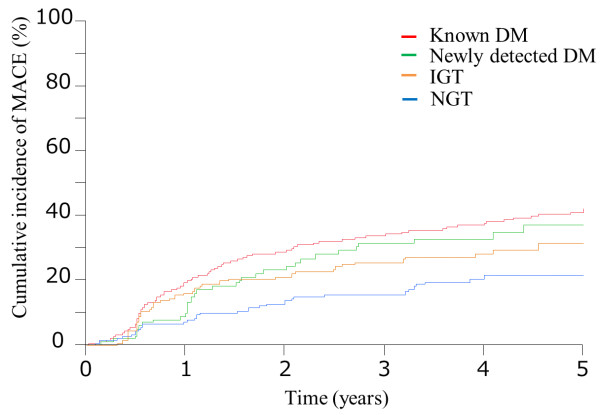
Kaplan-Meier plot of the cumulative incidence of the study endpoint between the 4 groups. Known DM = diabetes mellitus (red line); Newly diagnosed DM = diabetes mellitus (green line); IGT = impaired glucose tolerance (brown line); NGT = normal glucose tolerance (blue line).